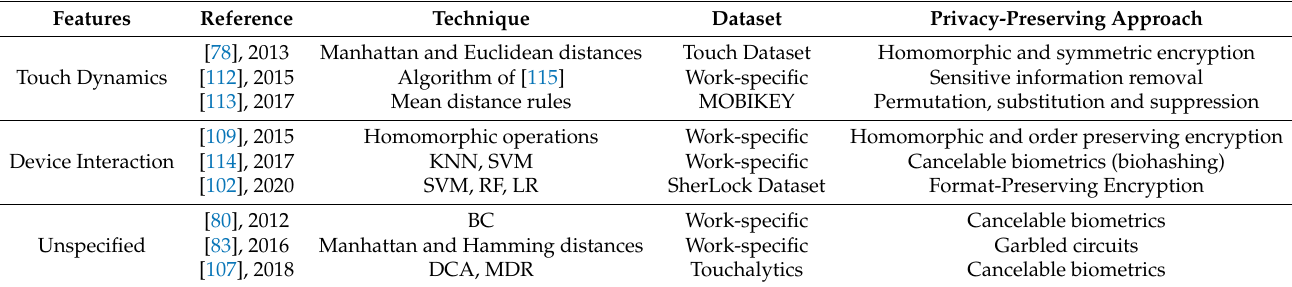
Table 3. Privacy-preserving CA literature summary (BC: BioCapsule, DCA: Discriminant Component Analysis, KNN: K-Nearest Neighbor, LR: Logistic Regression, MDR: Multiclass Discriminant Ration, RF: Random Forest, SVM: Support Vector